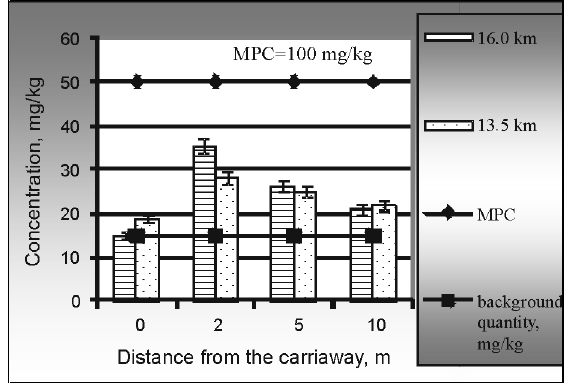
Fig. 2. Lead concentration in the roadside soil of the gravel road Krinčinas – Žvirgždė – Šukionys – Meiliūnai roadside. Pb concentration in the samples taken furthest from the carriageway reached 21.1 mg/kg (at 16.0 km) and 21.7 mg/kg (at 13.5 km). Pb concentrations at a distance of 10 m differ insignificantly (Fig.